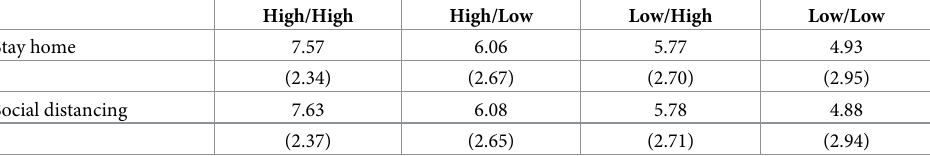
Table 2. Experimental outcomes.